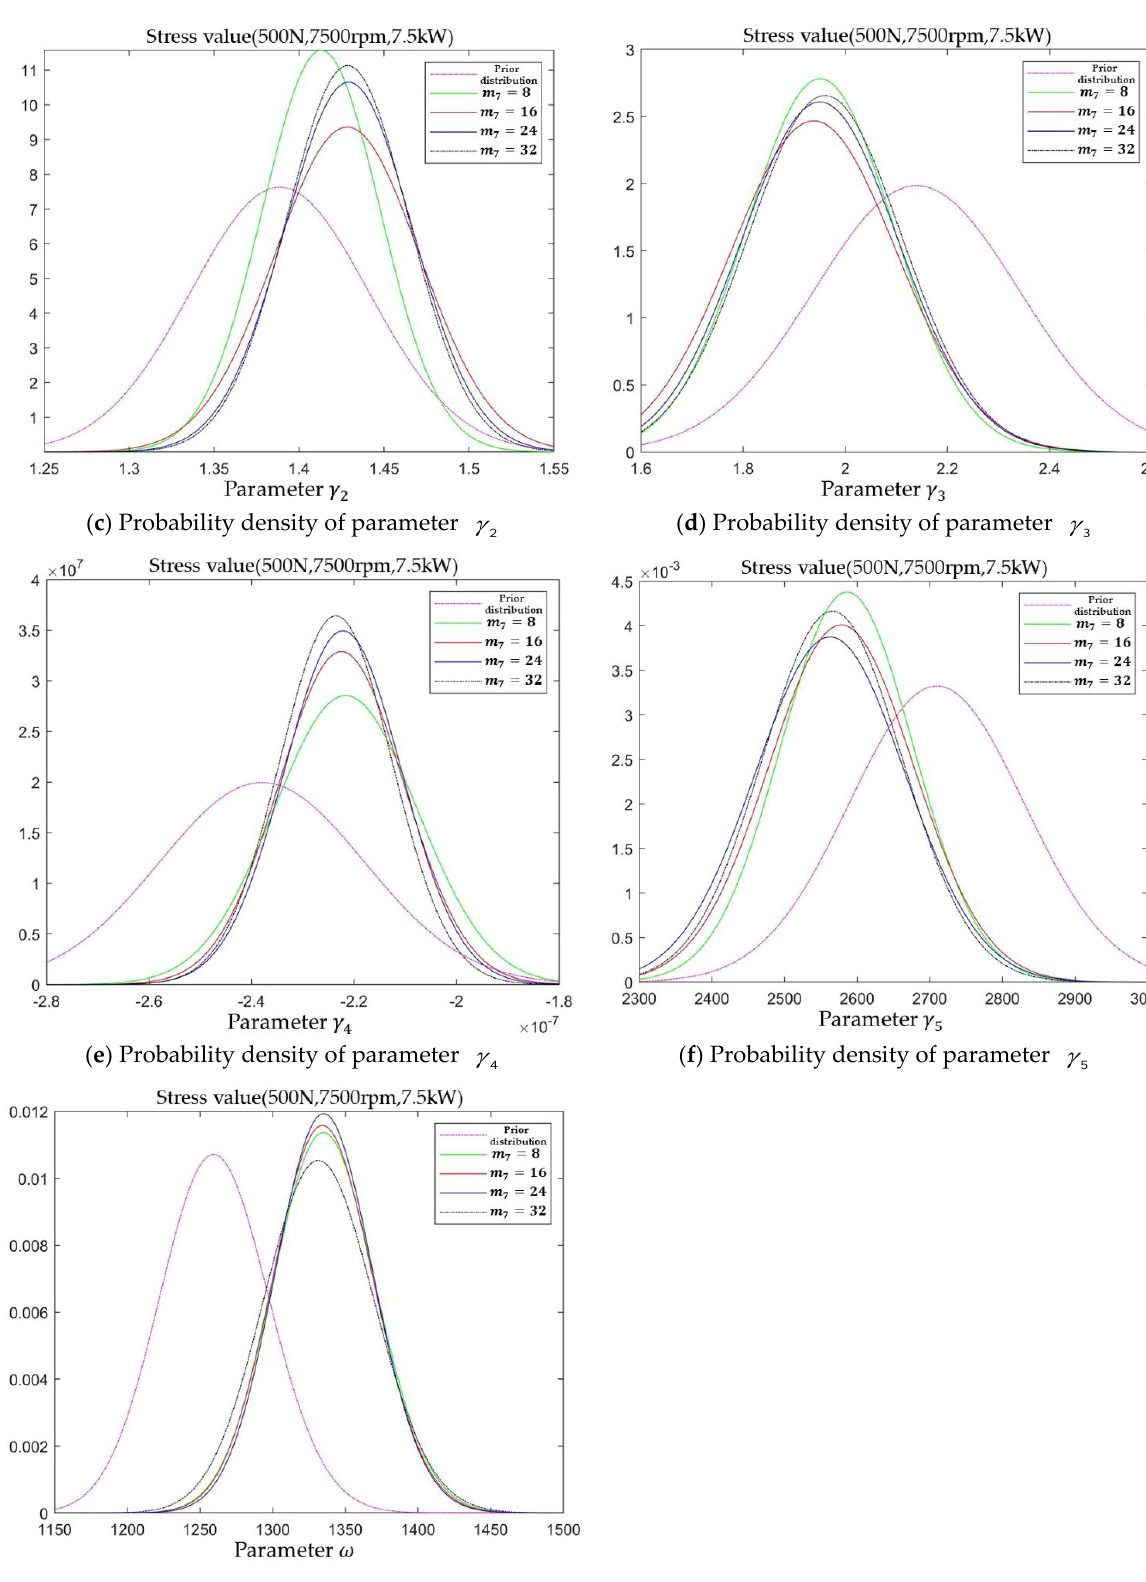
Figure 7. The update process of probability density of each model parameter with the test ( l = 7)